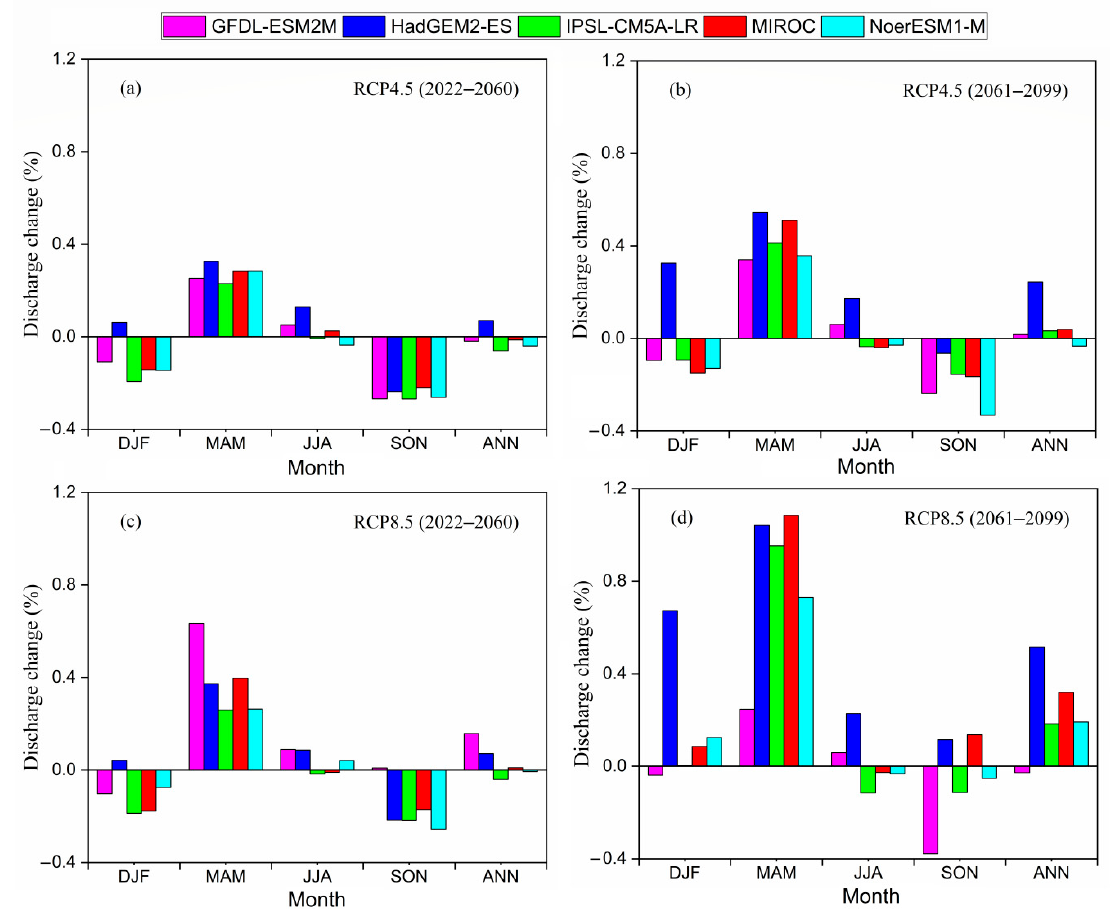
Figure 13. Seasonal and annual changes in the simulated discharge for five GCMs during the 2022–2060 and 2061–2099 time periods compared to the baseline period under ( a , b ) RCP4.5 and ( c , d ) RCP8.5 in the Vakhsh River Basin, Central Asia. ANN: annual.